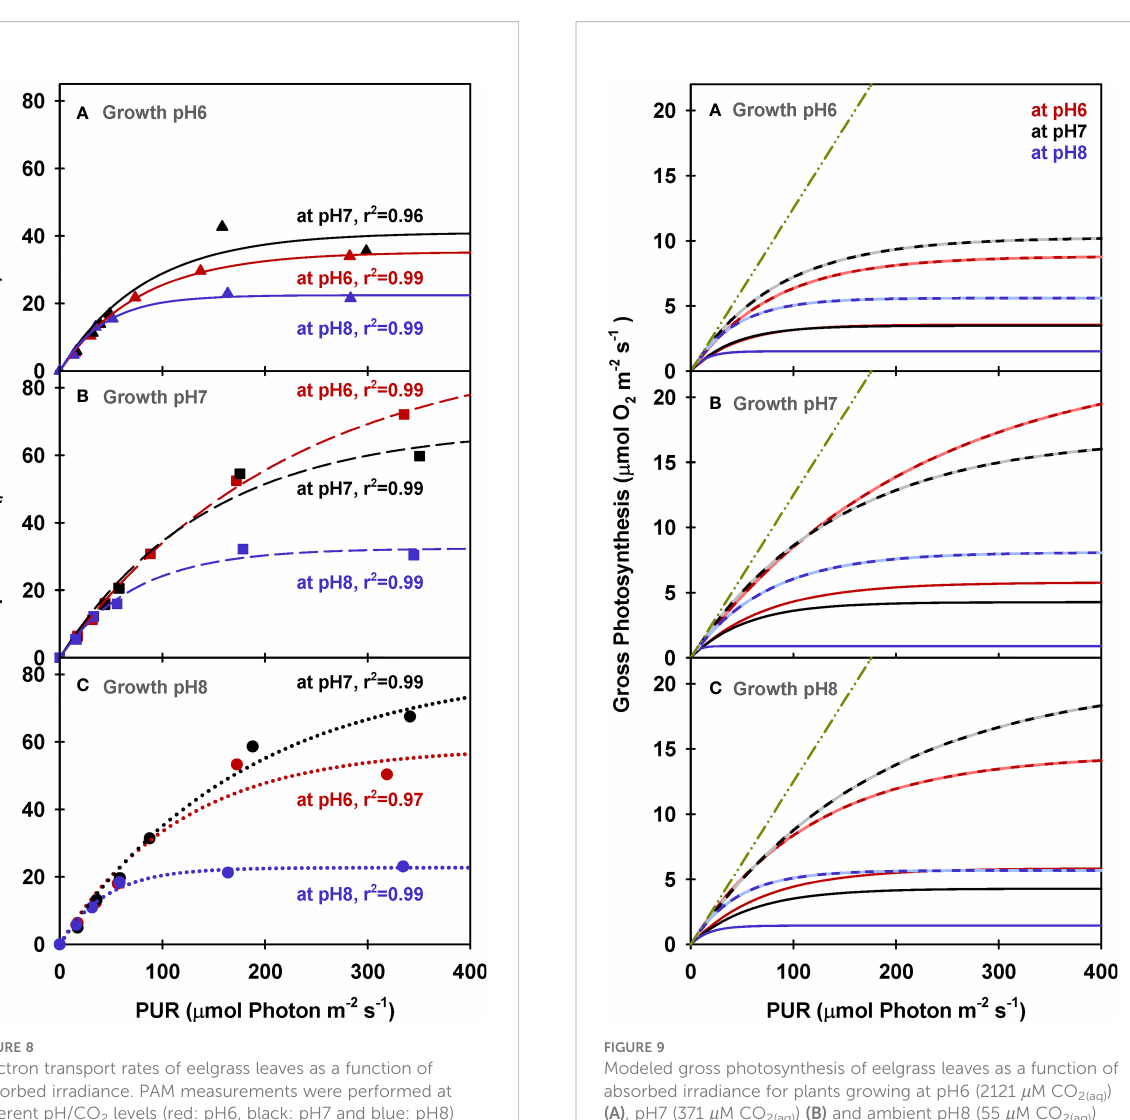
FIGURE 8 Electron transport rates of eelgrass leaves as a function of absorbed irradiance. PAM measurements were performed at different pH/CO 2 levels (red: pH6, black: pH7 and blue: pH8) using leaves grown at pH6 (2121 µ M CO 2(aq) ) (A) , pH7 (371 µ M CO 2(aq) ) (B) and ambient pH8 (55 µ M CO 2(aq) ) (C) . Curves were fi t using Equation (11).